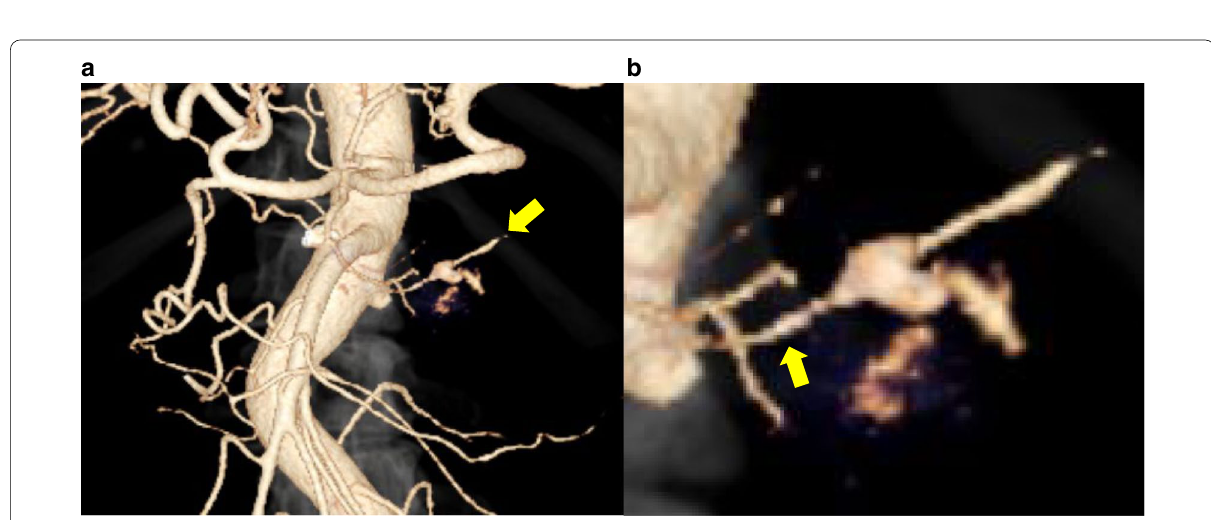
Fig. 2 Three-dimensional computed tomography angiography showing a transverse pancreatic artery aneurysm from the superior mesenteric artery (SMA). a Celiac artery and SMA branching from the aorta. An aneurysm (yellow arrow) is observed on the left side of the SMA. b An enlarged image of the aneurysm. It branched from the SMA (yellow